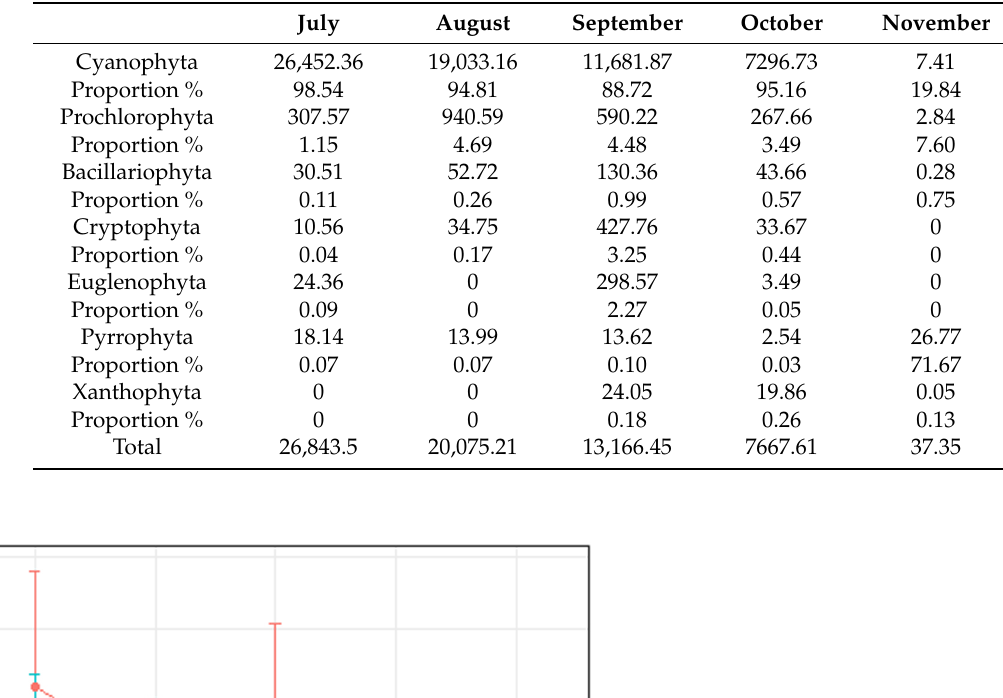
Table 5. Phytoplankton densities ( × 10 4 ) and proportions in the water around the artificial reefs.